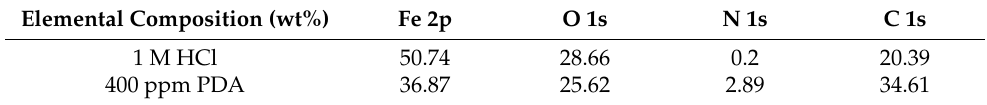
Figure 12. The high-resolution XPS spectra of the steel surface after exposure to 1 M HCl solution and in the presence of 400 ppm NCDs, ( a , b ) N 1s, ( c , d ) C1s, ( e , f ) O 1s and ( g , h ) Fe 2p. 4. Conclusions In this investigation, NCDs were successively prepared by a hydrothermal process of dopamine, and corresponding corrosion inhibition behavior of NCDs on the Q235 car- bon steel in 1 M HCl solution was systematically studied in terms of the NCD concentra- tion, exposure time and temperature. As confirmed by electrochemical and weight loss results, NCDs acting as a mixed-type corrosion inhibitor could effectively inhibit the acid corrosion of Q235 carbon steel. The inhibition efficiency of NCDs increased with the in- creasing NCD concentrations, and the highest inhibition efficiency of up to 96.1% was